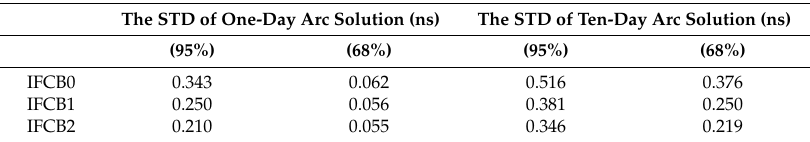
Figure 14. The clock difference series of the two selected time-links using the European Space Agency (ESA) and German Research Center for Geosciences (GFZ) products. Table 8. The uncertainty (STD) of the GLONASS PPP solutions using ESA products with fixed coordinates (ns).